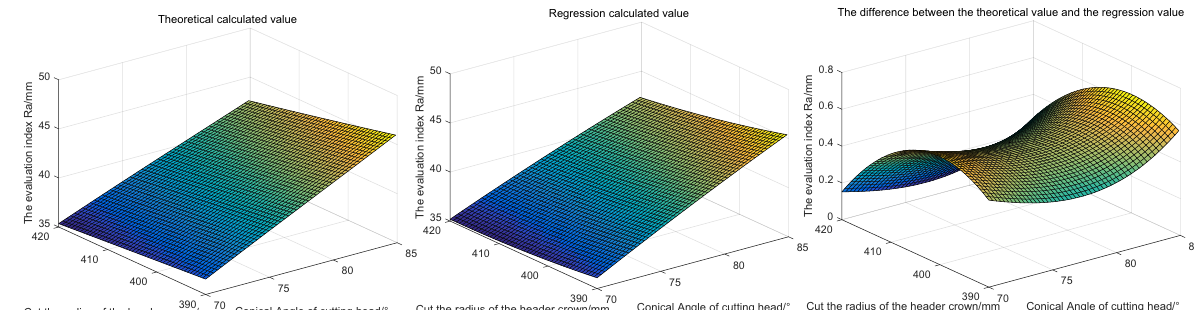
Figure 15. The influence of different cut head crown radius and cut head conical Angle on the evaluation